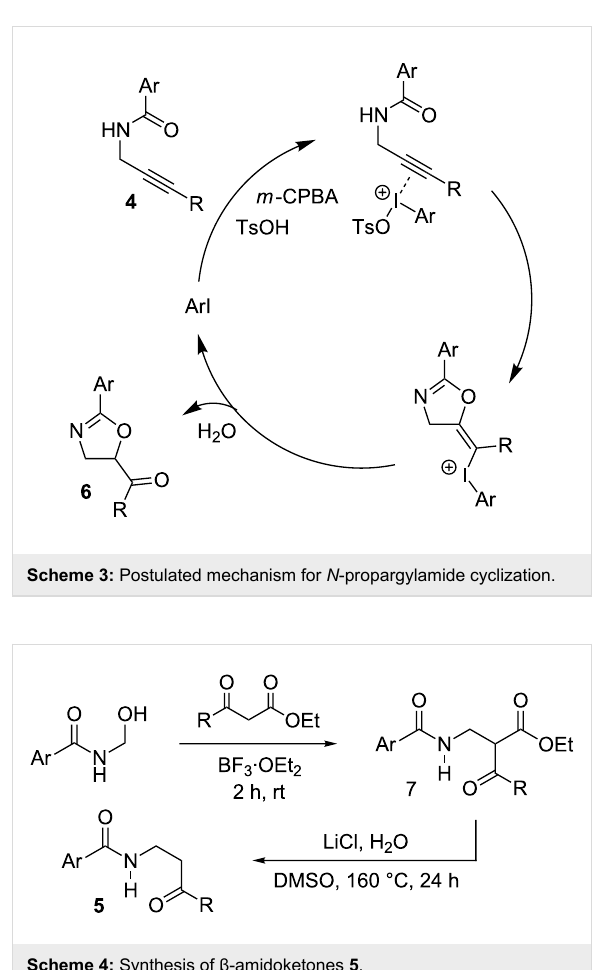
Scheme 4: Synthesis of β -amidoketones 5